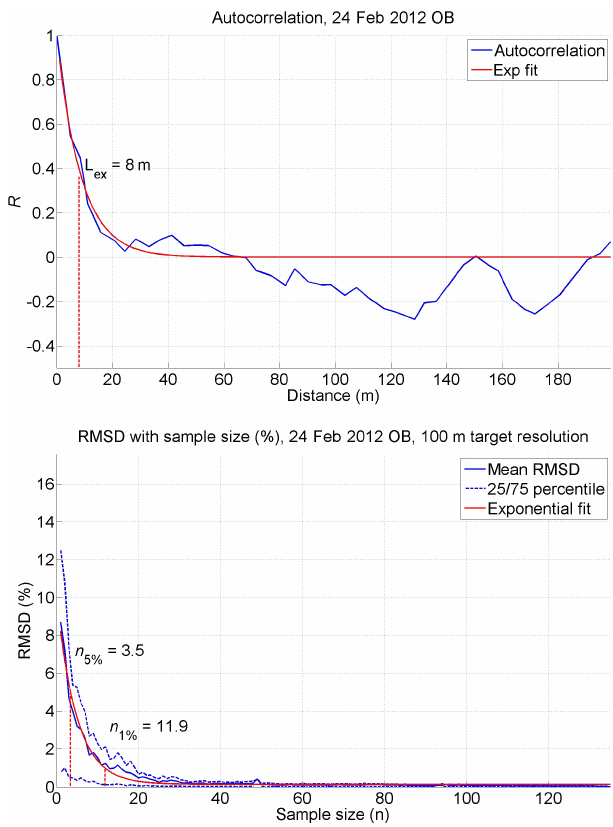
Figure 6. Top: an example of an exponential fit to the calculated autocorrelation of snow depth measured over wetlands (OB) on 24 February 2012. Bottom: an example of mean RMSD against “true” snow depth with increasing sample size n for the same transect. Number of samples needed to achieve RMSD <5 and <1% indi-